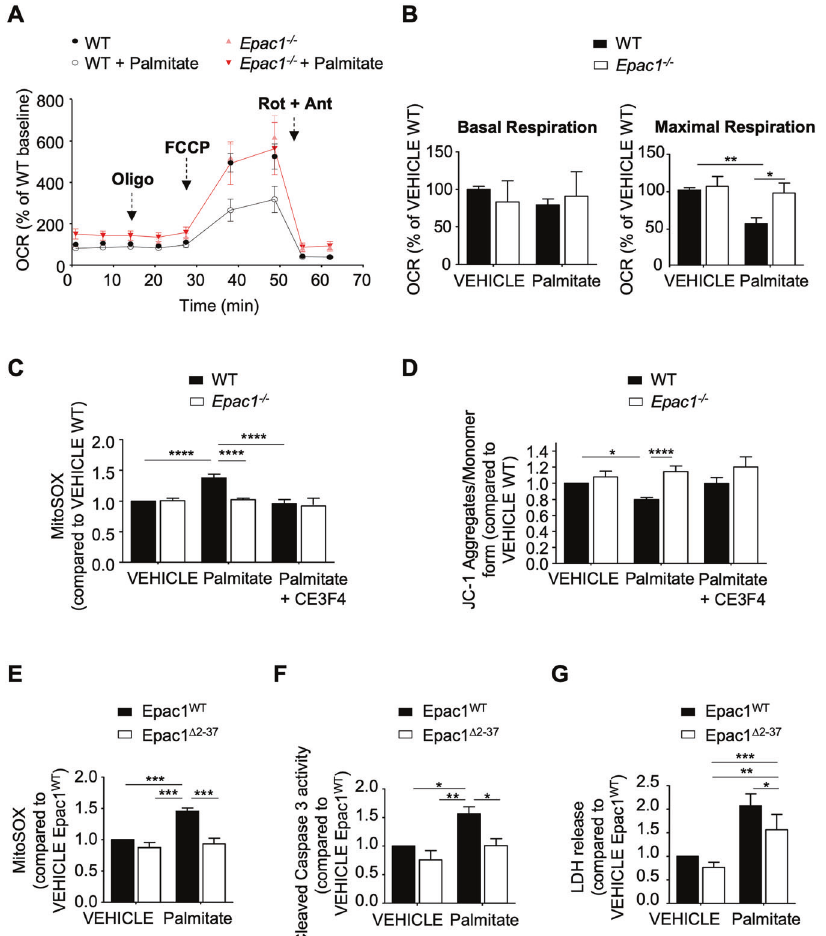
Fig. 2 Epac1 promotes mitochondrial aberrations leading to cardiomyocyte death. A Measurements of oxygen consumption rate (OCR) in adult cardiomyocytes isolated from WT or Epac1 − / − mice, incubated or not (VEHICLE) with palmitate (150 μ M, 2 h) after oligomycin, FCCP, antimycin A or rotenone (1 µM) addition ( n = 4 – 5). B Graphical representation of basal or maximal respiration of WT and Epac1 − / − cardiomyocytes subjected to palmitate-induced metabolic stress ( n = 4 – 5). C, D Quanti fi cation of mitochondrial ROS using MitoSOX ( C )